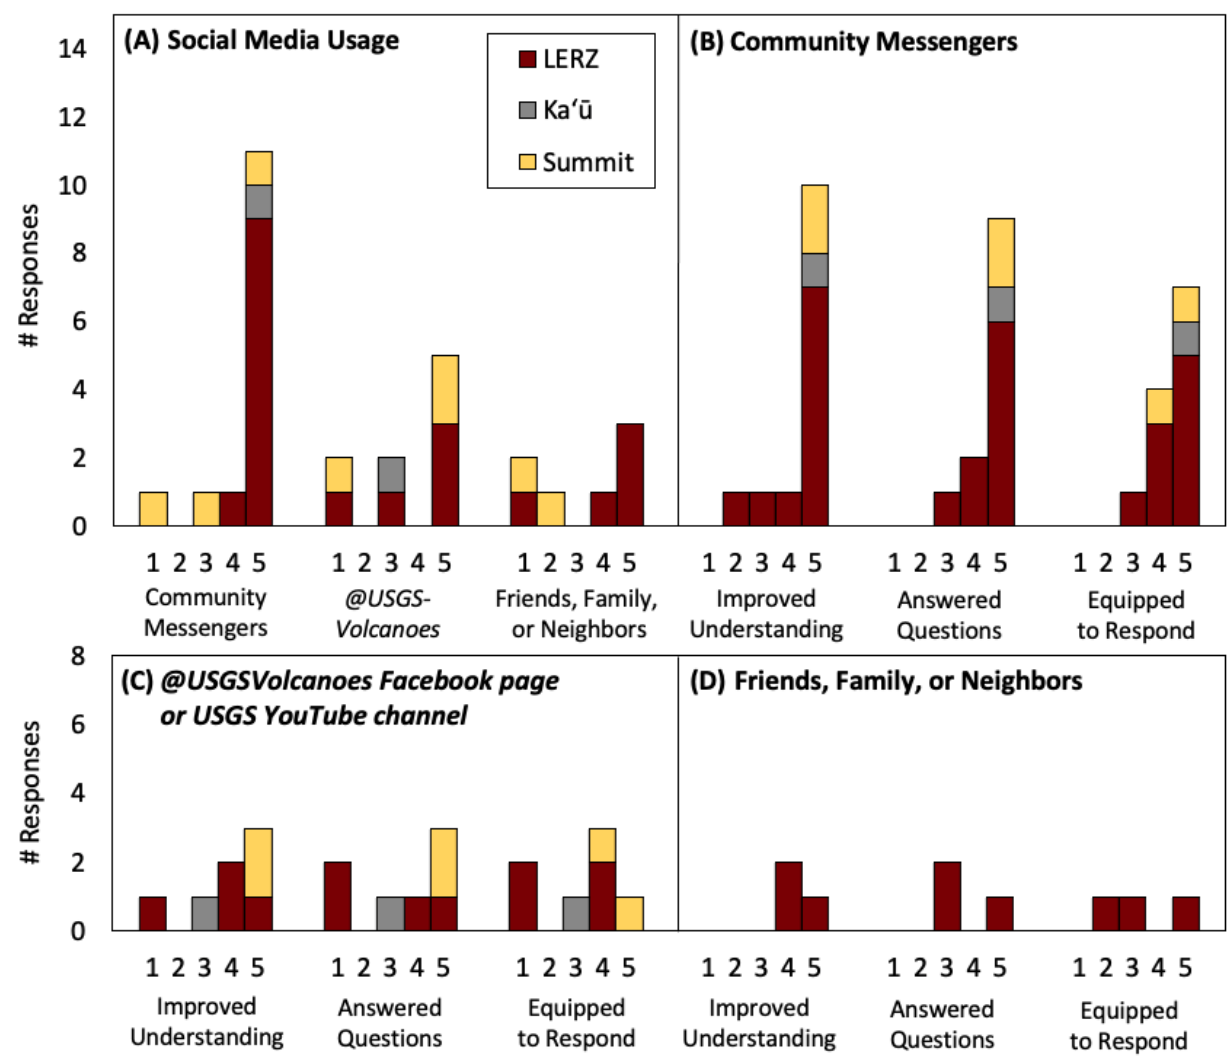
Figure 5: Participants’ responses regarding eruption information communicated through social media. Panel [A] shows partici- pants’ reported frequency in following the Facebook pages of community messengers, @USGSVolcanoes, or friends, family, or neighbors. Panels [B]–[D] plot participants’ Likert-type scores for each of the three groups of messengers in response to